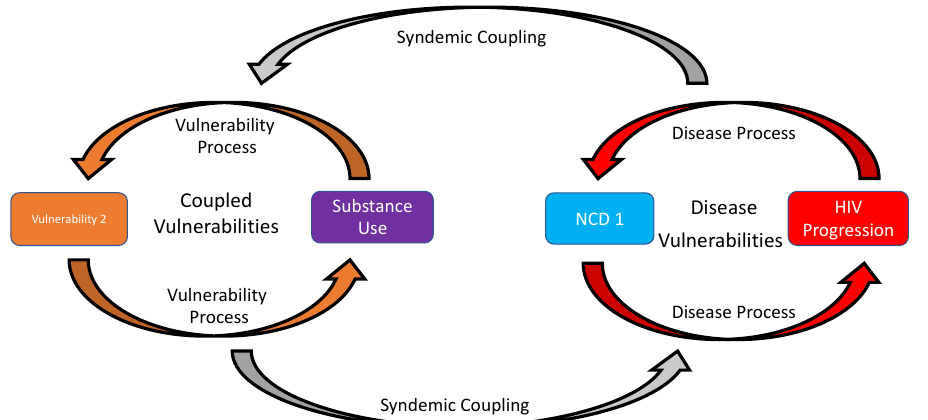
Figure 1. Syndemic coupling occurs when both a disease and a non-disease system interact as a coupled ecosystems that can amplify or attenuate HIV disease progression. The coupled vulnerabilities (orange arrows) include substance use and other vulnerabilities (e.g., poverty, intimate partner violence, etc.) interact in a vulnerability process can reinforce maladaptive behaviors. Vulnerability process (e.g., social, cognitive, socioeconomic, etc.) can couple with the disease process (red arrows) in that HIV progress can couple with non-communicable disease (e.g., HTN, and CVD) or another communicable disease (e.g., TB, Hepatitis B, etc.) and reinforce that disease processes. Both the disease process and vulnerabilities process are co-occurring and can either amplify or attenuate each system based on syndemic coupling (gray arrows).